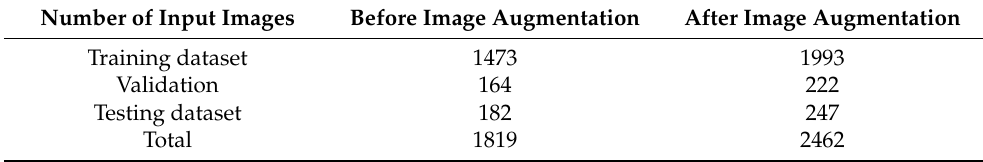
Table 3. Number of image dataset input for the training, validation, and testing